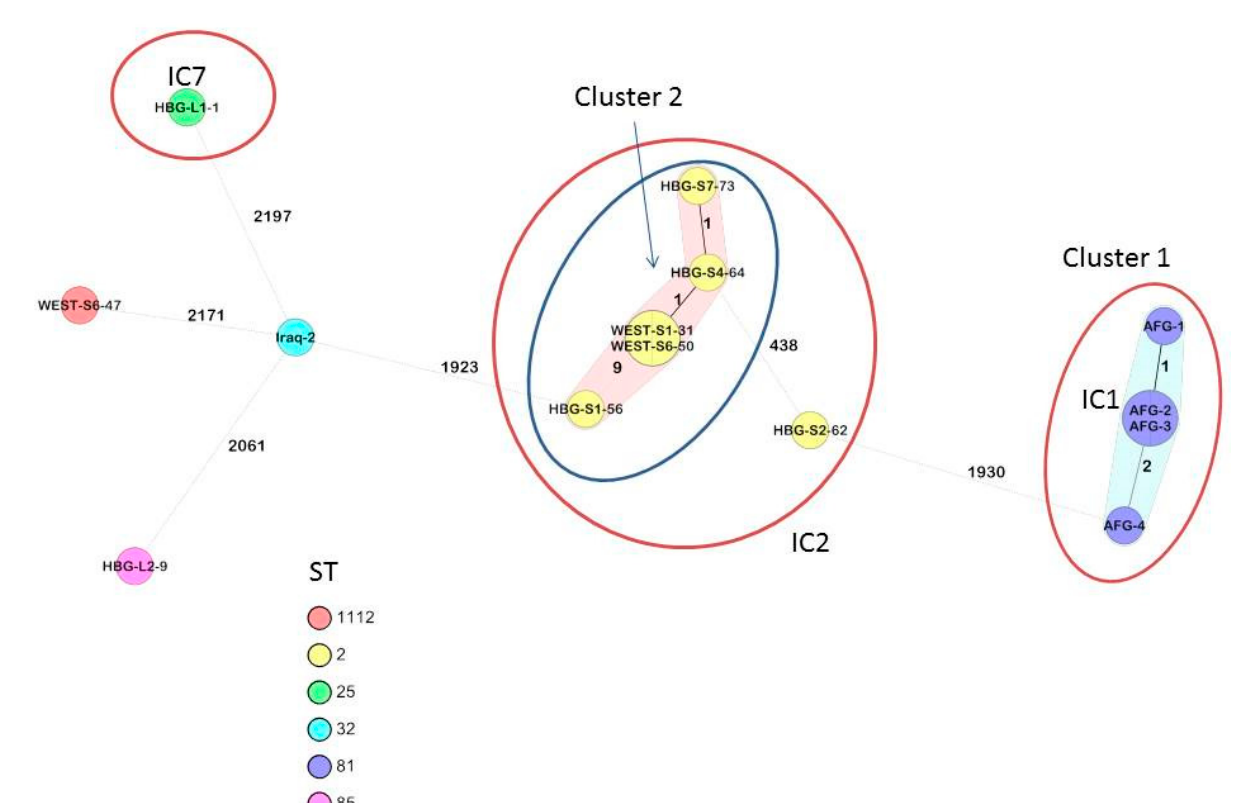
Figure 1. Minimum spanning tree of the A. baumannii strains based on 2390 target alleles (core genome). Isolate numbers are within the nodes, and the numbers between the nodes indicate the number of alleles that were different. Isolates are colored based on their Pasteur sequence type.